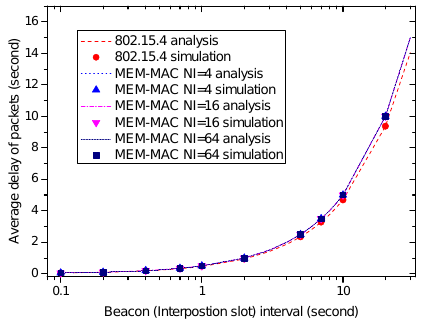
Figure 10. The effects of the beacon frame interval and interposition interval on average frame